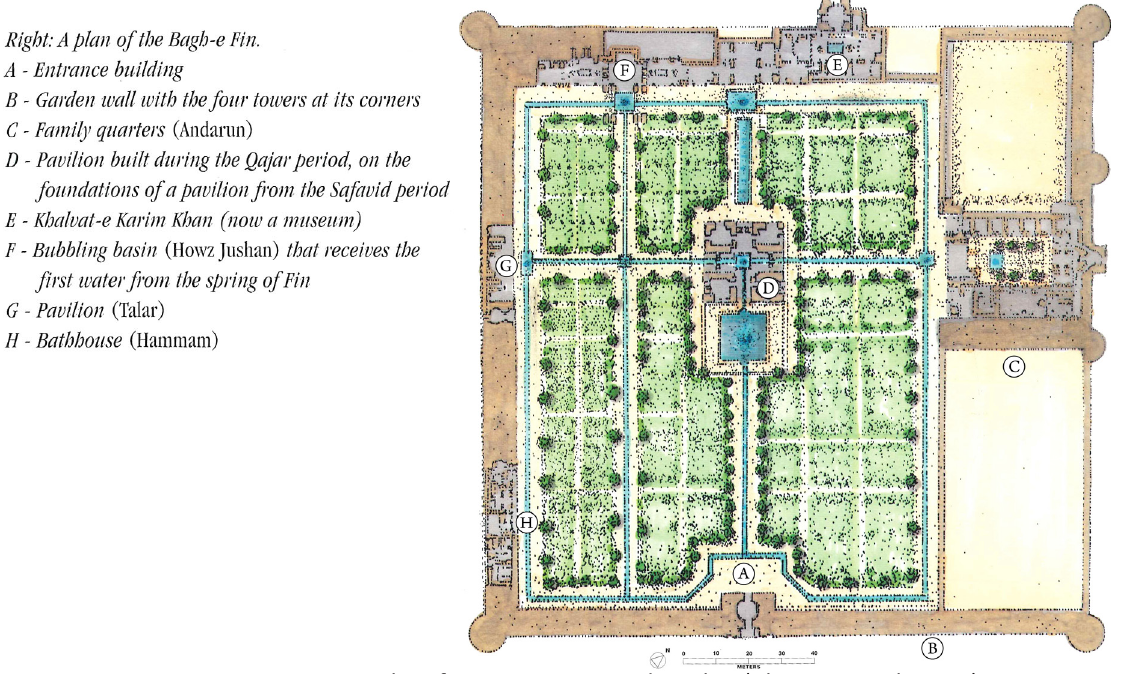
Figure 10. Hierarchy of spaces in Fin Garden plan (Khansari et